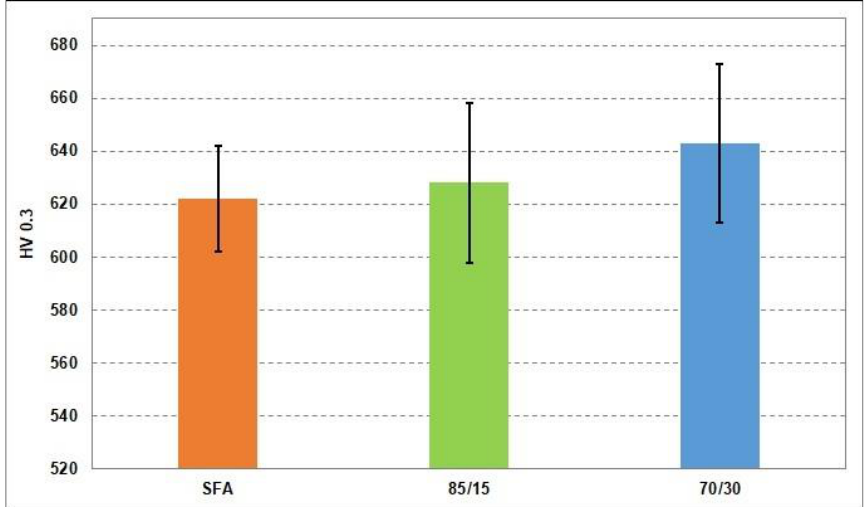
Figure 4. Microhardness values of the coatings.